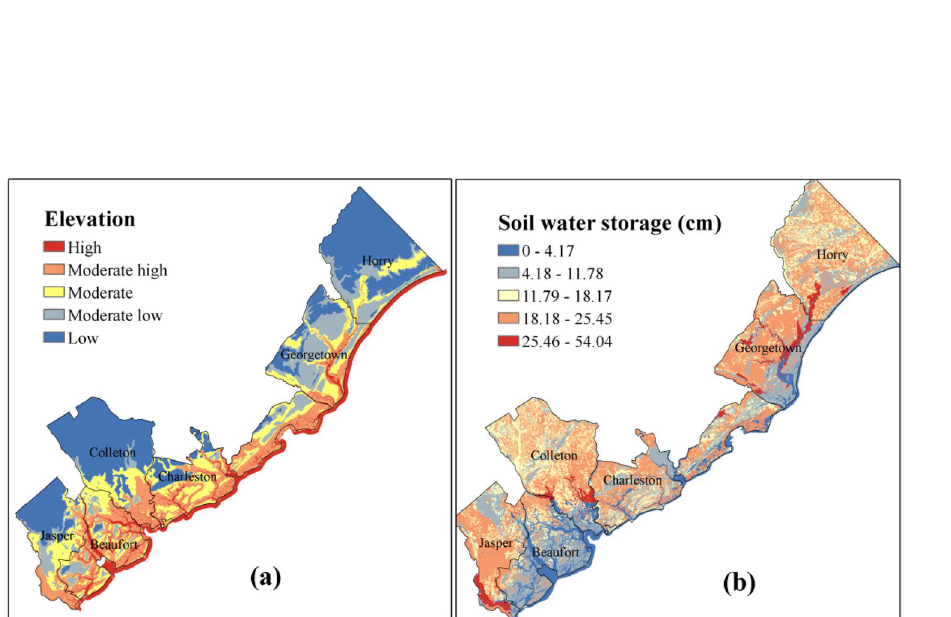
Figure 5. Physical vulnerability indicators ( a ) Elevation, ( b ) Available water storage in